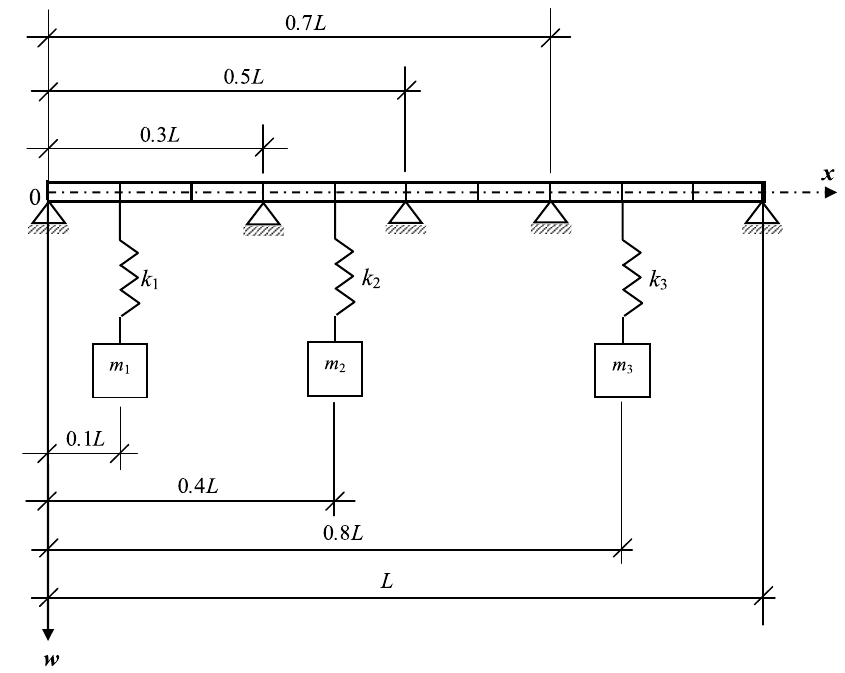
Fig. 9. A four-span Reddy-Bickford beam carrying three intermediate spring-mass